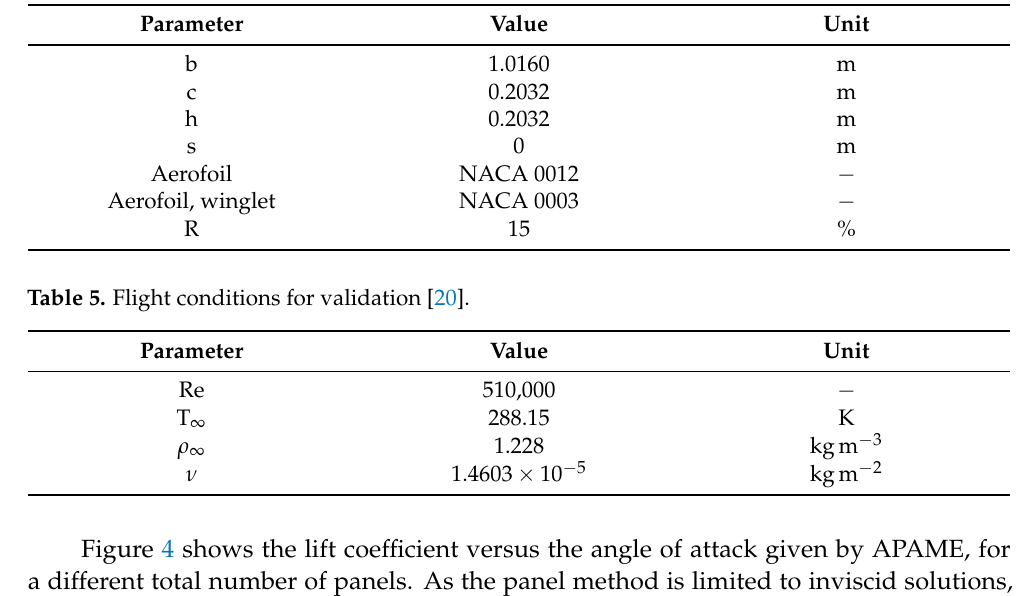
Table 4. Geometrical parameters of the box wing for validation [20].